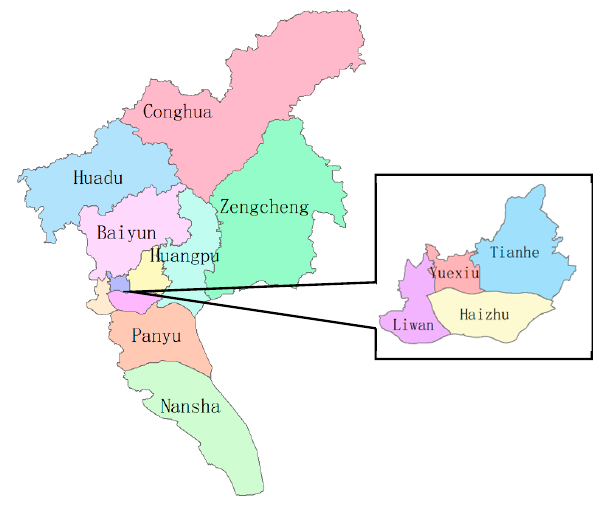
Figure 1. District map of Guangzhou,